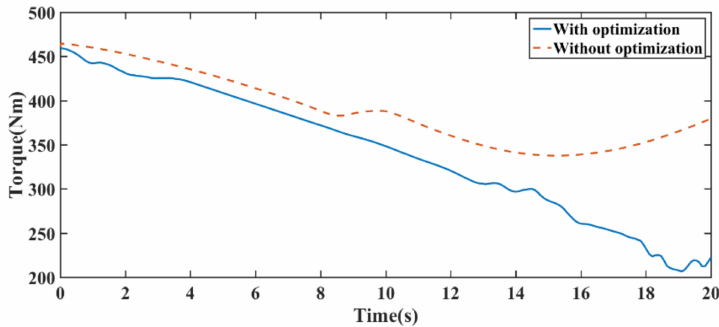
Figure 14. Torque exerted on the guardrail by the